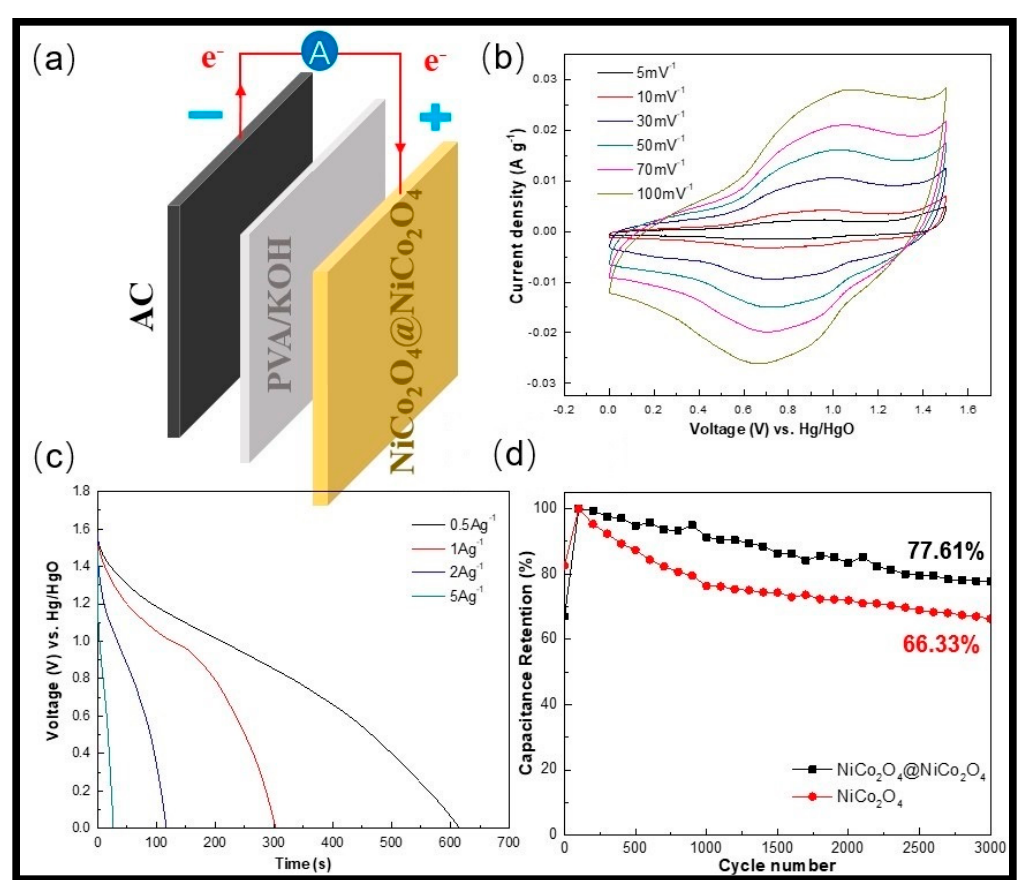
Figure 8. ( a ) Graphical presentation of the asymmetric supercapacitor (ASC) device, ( b ) CV curves of the ASC device at versatile scan rates, ( c ) charge–discharge curves at versatile current densities, and ( d ) the cycle stability of the NiCo 2 O 4 and NiCo 2 O 4 @NiCo 2 O 4 devices at 10 Ag − 1 for 3000 cycles.